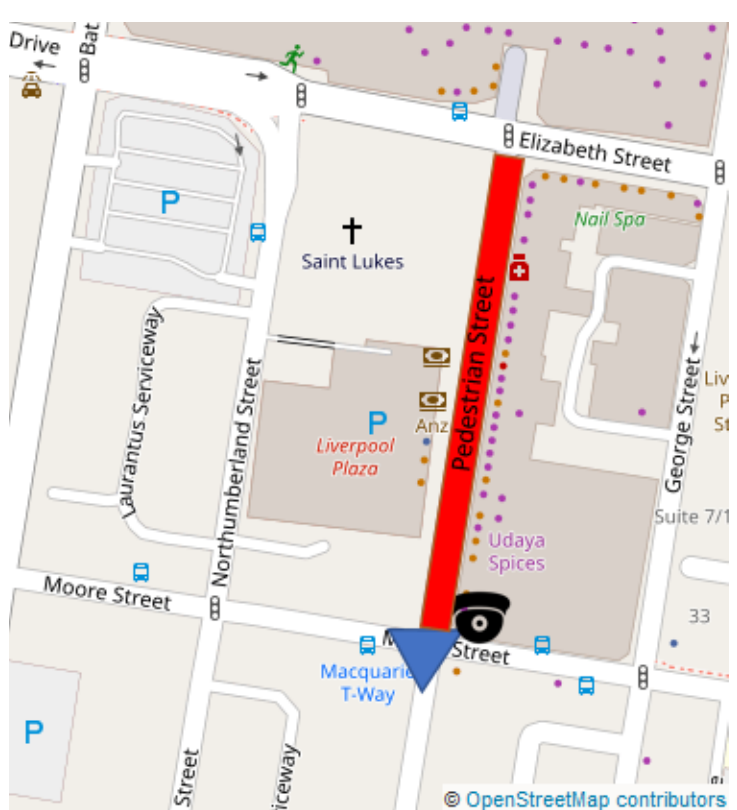
Figure 17. The sensor is located at the center of the city, next to a pedestrian street (highlighted in red). The field of view of the camera is represented in blue.